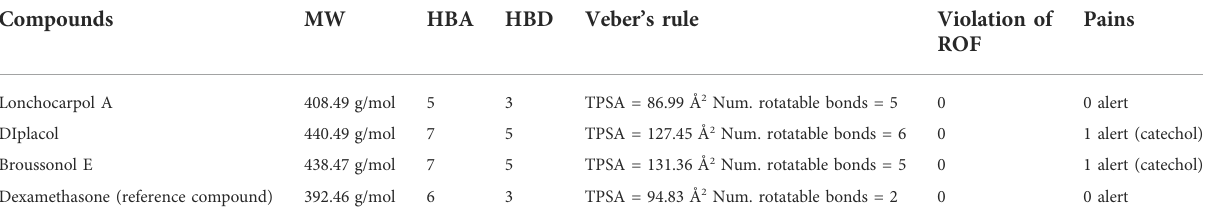
TABLE 8 Drug-likeness prediction of top four compounds. Compounds